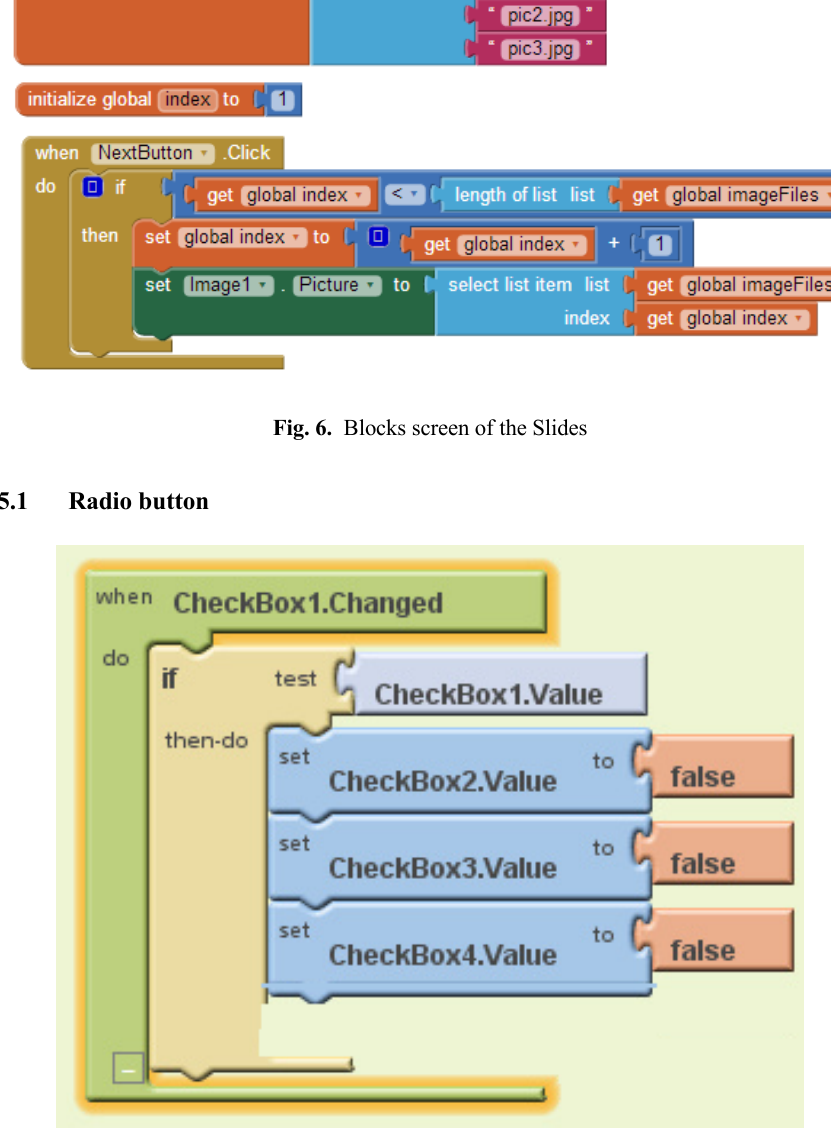
Fig. 7. Blocks screen of the radio